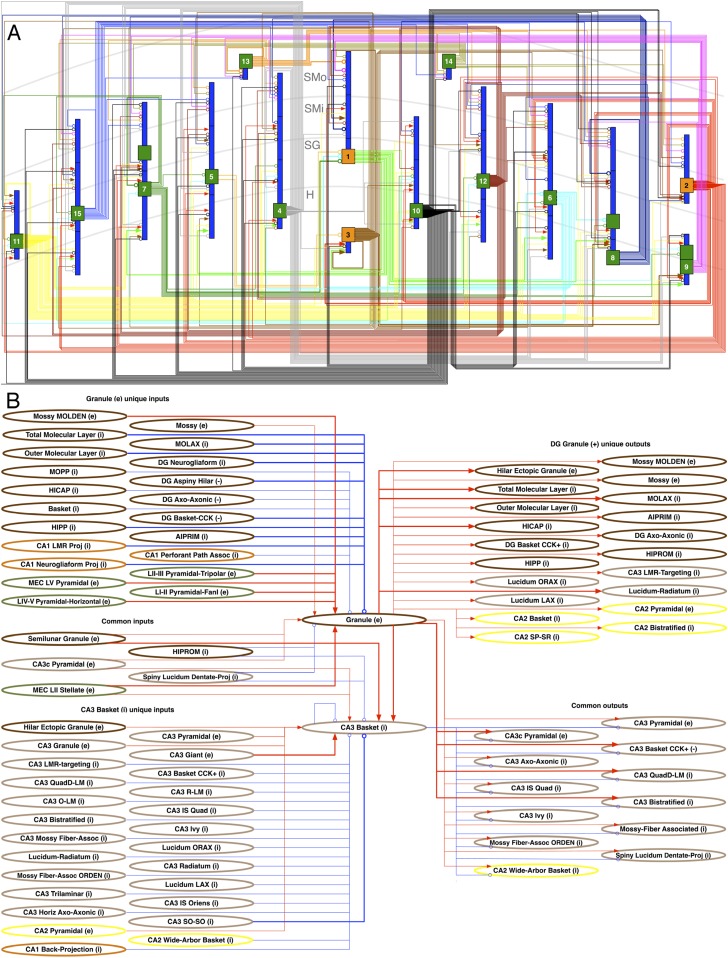
Neuron type circuitry.(A) Circuit diagram of selected neuron types in DG (full diagram: hippocampome.org/php/images/connectivity/DG_Circuit_Diagram.jpg or hippocampome.org/php/images/connectivity/DG_Circuit_Diagram.graffle.zip). Axonal connections from pre-synaptic somata (orange glutamatergic, green GABAergic) to post-synaptic somata or dendrites (blue) have unique line colors for each pre-synaptic type for clarity. Lines ending in arrows and open circles indicate, respectively, glutamatergic and GABAergic connections; 22 known (thick lines) and 231 potential (thin) connections are depicted. 1: Granule. 2: Semilunar Granule. 3: Mossy. 4: AIPRIM. 5: Axo-axonic. 6: Basket. 7: Basket CCK+. 8: HICAP. 9: HIPP. 10: HIPROM. 11: MOCAP. 12: MOLAX. 13: MOPP. 14: Neurogliaform. 15: Outer Molecular Layer. (B) Pre- and post-synaptic connections for DG Granule and CA3 Basket cells. Red lines ending in arrows indicate glutamatergic connections, and blue lines ending in open circles indicate GABAergic connections. Thick and thin lines indicate, respectively, known and potential connections. Neuron types are color coded by area of origin (as in Figure 1).